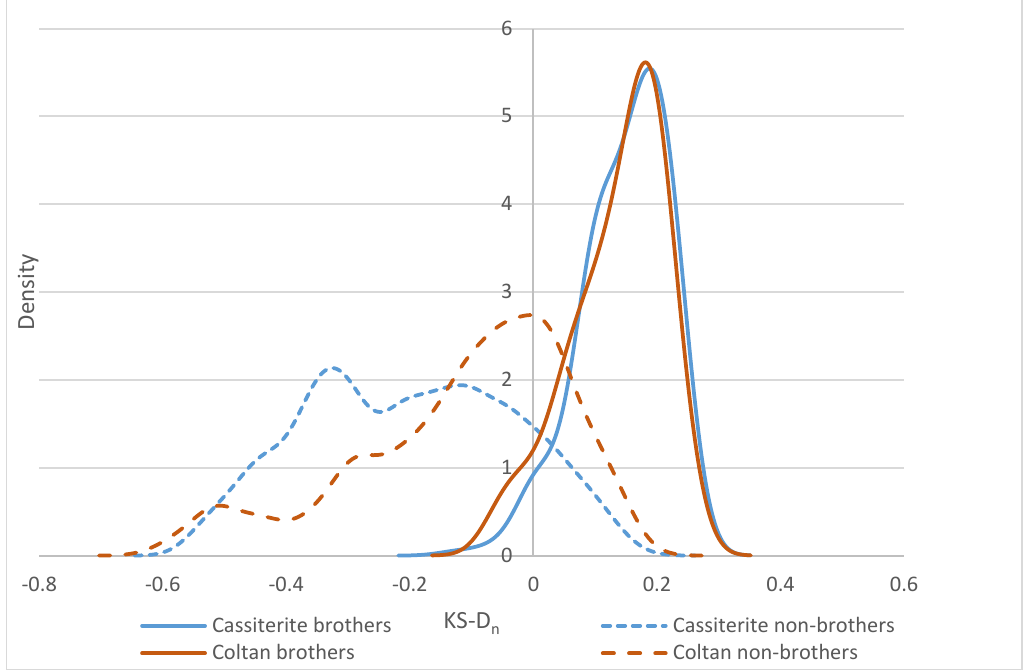
Figure 2. Distributions of brother and non-brother comparison test sets of KS-D n of cassiterite and coltan for the respective DC calculated with 2σ.